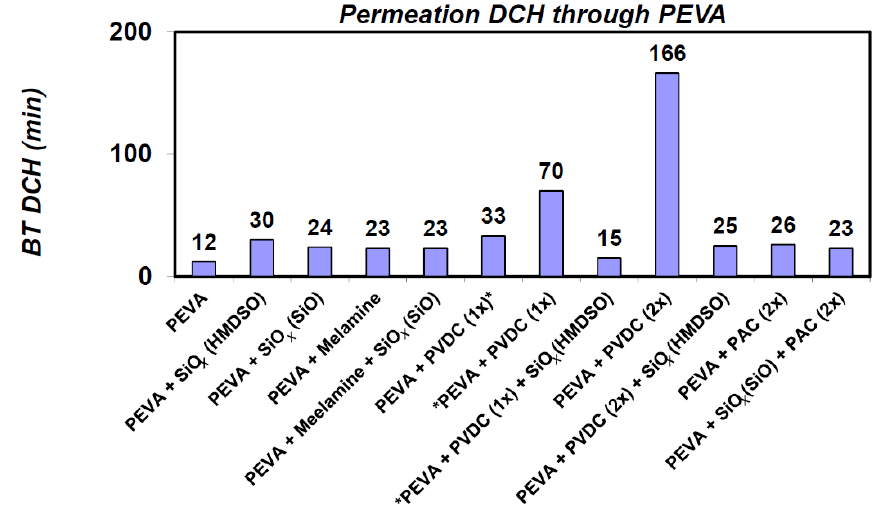
The resistance of the PEVA foil modified with different barrier layers against 1,6-dichlorohexane